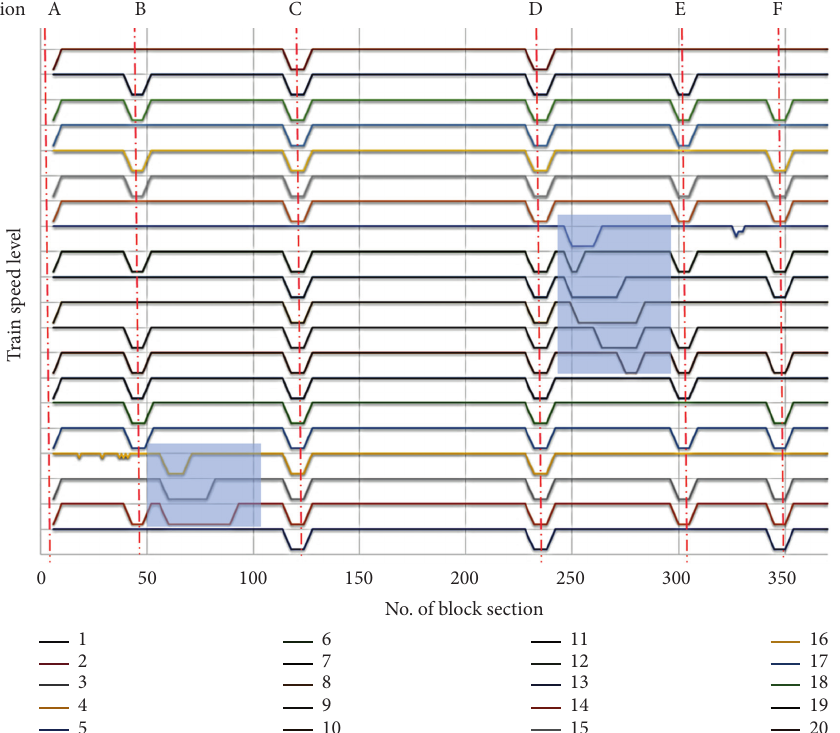
Figure 10: Speed levels of 20 trains along their